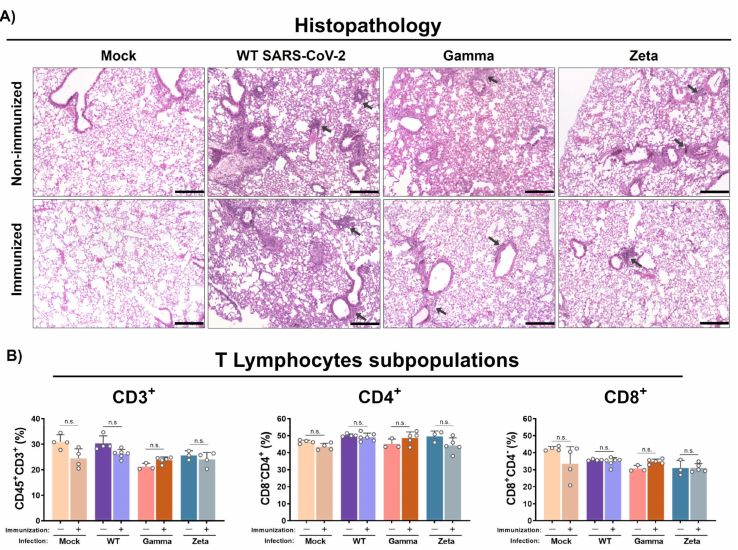
Figure 5. Histopathology and T lymphocyte subpopulation analysis from mouse lungs. Lungs from immunized and nonimmunized mice were collected after 3 days of infection. ( A ) Superior right lobe processed and stained with H&E. ( B ) Middle and inferior lobes collected and evaluated for recruitment of T lymphocyte subpopulations. n = 3 for nonimmunized groups and n = 5 for immu- nized groups. Black arrows, mixed inflammatory infiltrates. Scale bar = 200 µ m. Statistical analysis conducted by one-way ANOVA followed by Tukey’s post hoc test. n.s. = not statistically